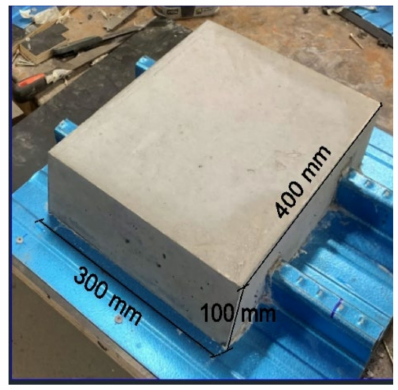
Figure 5. Specimen (dimensions are in